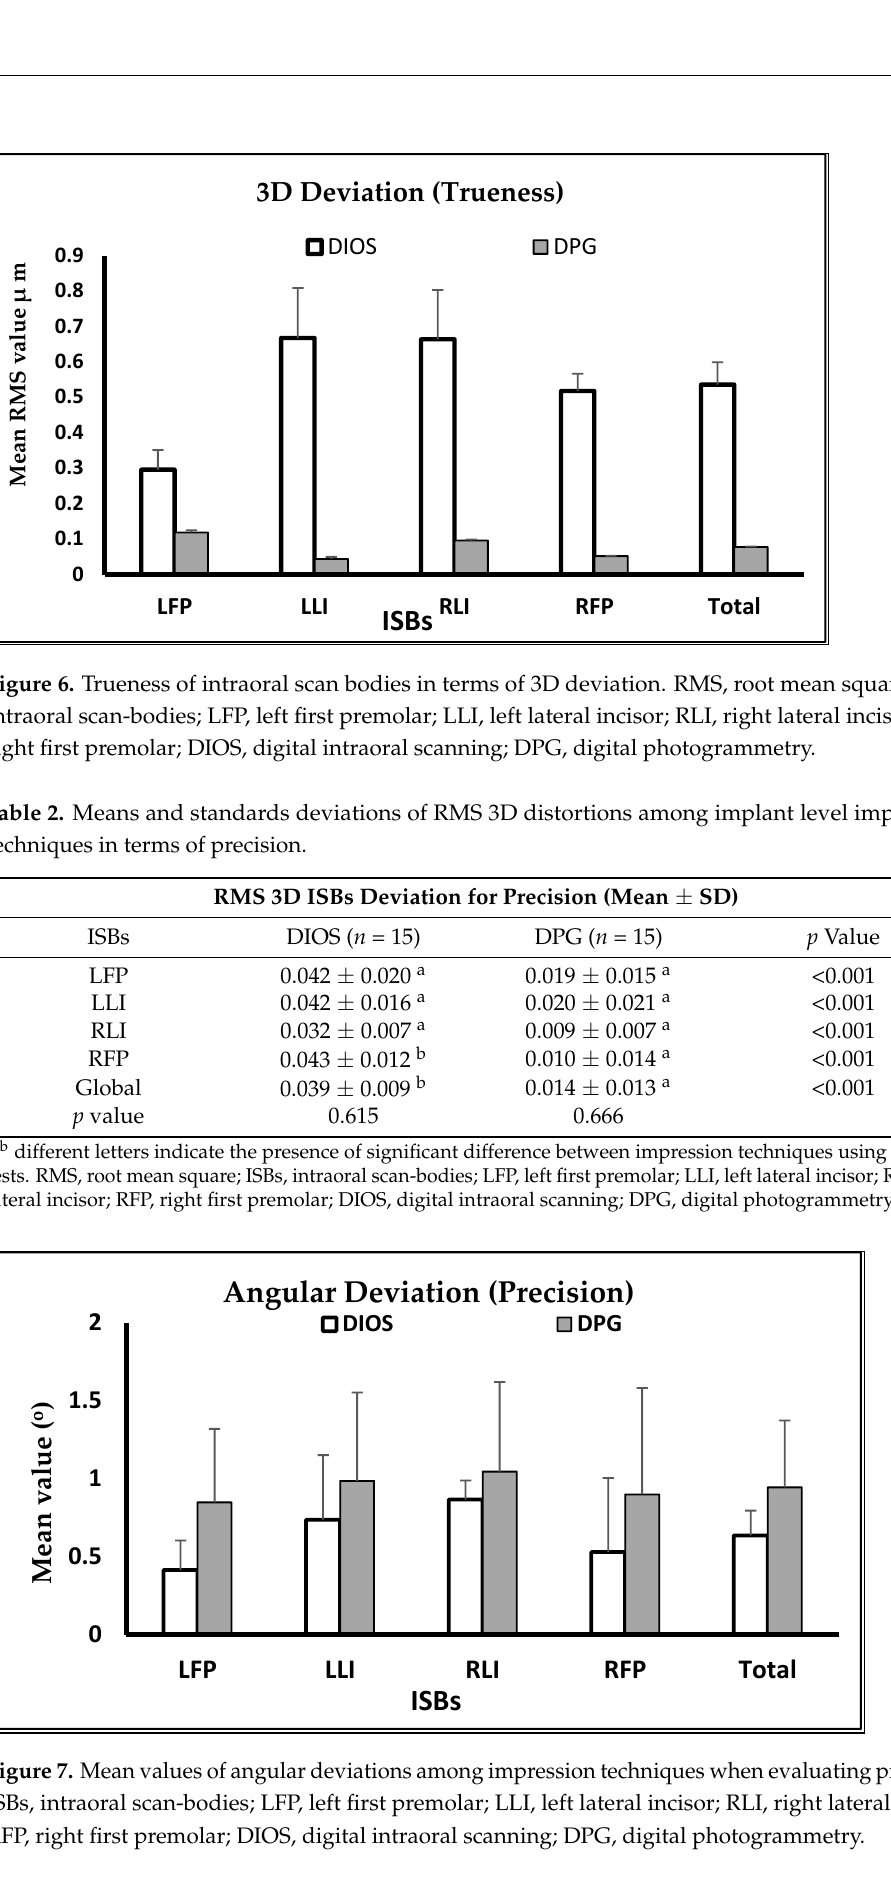
Table 1. Means and standards deviations of angular distortions among implant level impression techniques in terms of trueness. Figure 7. Mean values of angular deviations among impression techniques when evaluating precision. ISBs, intraoral scan-bodies; LFP, left first premolar; LLI, left lateral incisor; RLI, right lateral incisor; RFP, right first premolar; DIOS, digital intraoral scanning; DPG, digital photogrammetry.